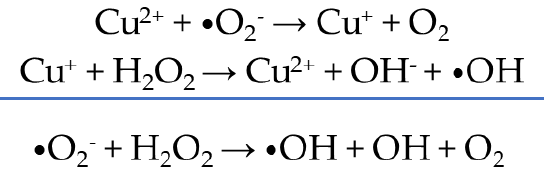
Figure 14. Mechanism of formation of ROS from Cu 2+ .